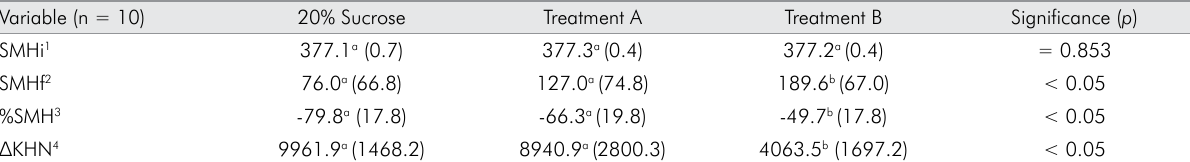
Table 1. Mean and standard deviation (SD) of the variables analyzed in the enamel surface. Variable (n = 10)